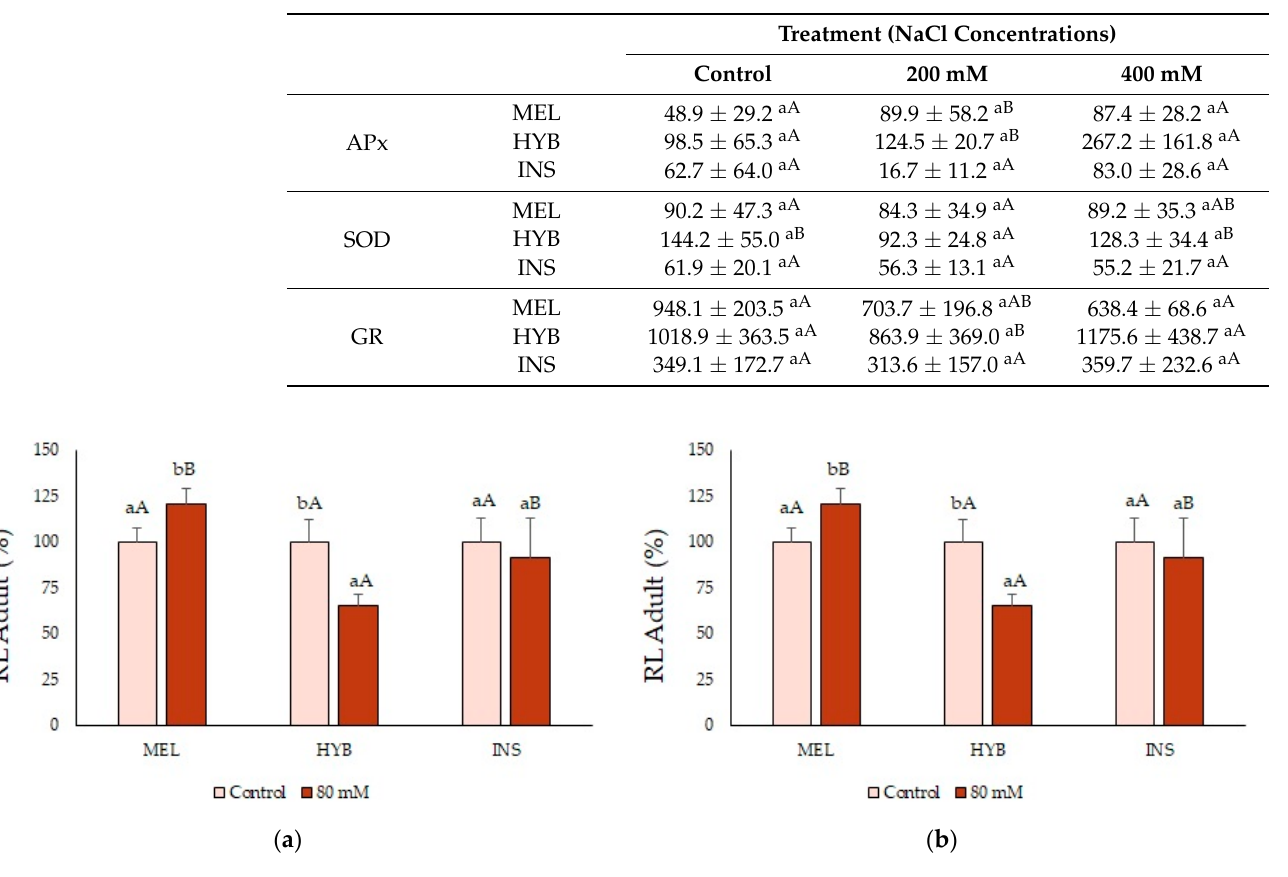
Figure 7. Root length (RL) ( a ) and leaf surface (LS) ( b ) (mean ± SD; n = 5) in adult plants of Solanum melongena (MEL), Solanum insanum (INS) and their hybrid (HYB) in control conditions and under long-term (eight weeks) 80 mM NaCl irrigation. Values are shown as percentages of the correspond- ing controls of each genotype, taken as 100%, with absolute values for RL (cm): [MEL = 65.2, HYB = 68.6, INS = 71.6] and LS (cm 2 ): [MEL = 141, HYB = 172.4, INS = 140.8]. Different lowercase letters within the same genotype indicate statistically significant differences between treatments, and dif- ferent uppercase letters within the same treatment indicate statistically significant differences be- tween genotypes ( p < 0.05), according to the Student–Newman–Keuls multiple range test.